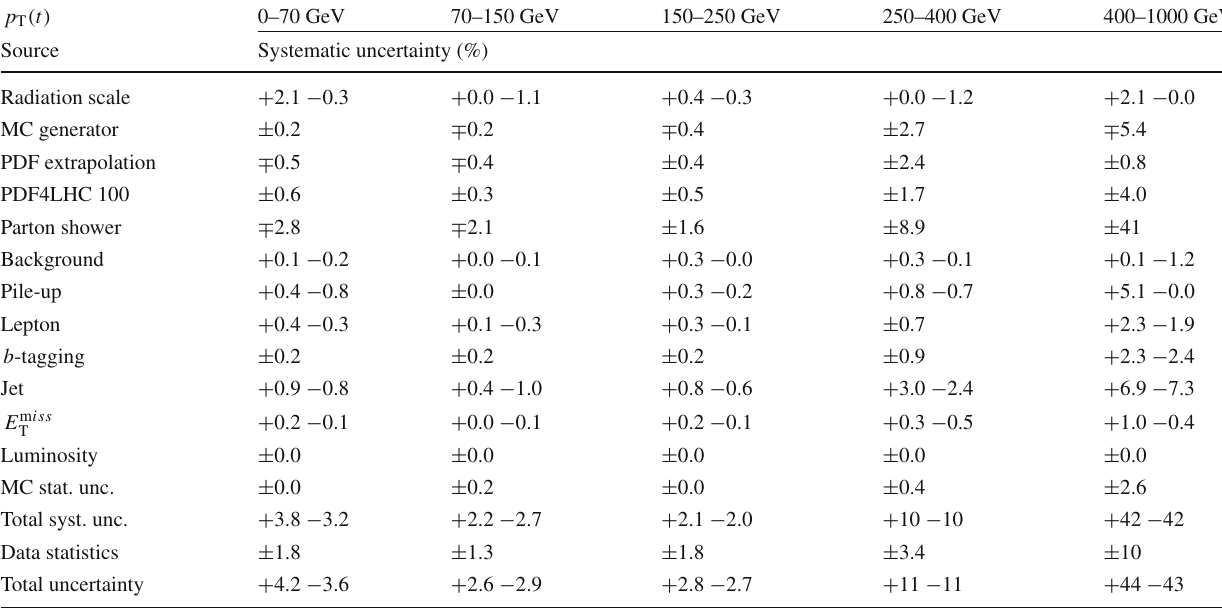
Table 3 Summary of the sources of uncertainty in the normalised fidu- cial differential cross-section as a function of p T ( t ) . The uncertainties are presented as a percentage of the measured cross-section in each bin. Entries with 0.0 are uncertainties that are less than 0.05 in magnitude.